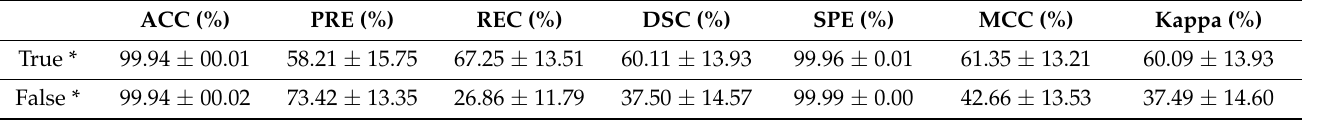
* True represents output with data enhancement. False is outputs without data enhancement. Table 3. Chi-square tests for data augmentation.